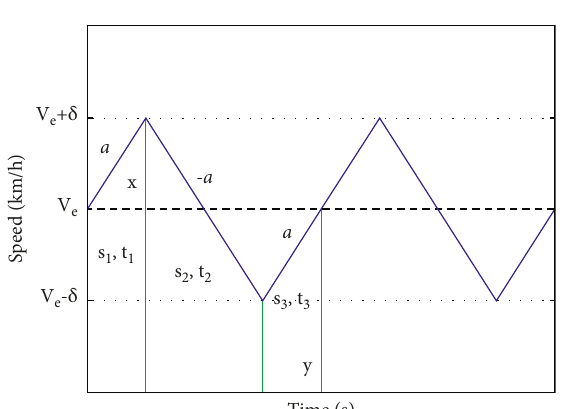
Figure 3: Schematic diagram of speed